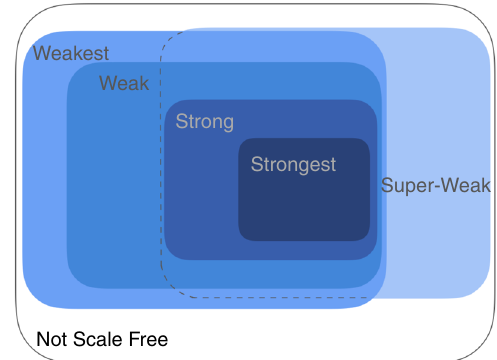
Fig. 2 Taxonomy of scale-free network de fi nitions. Super-Weak meaning that a power law is not necessarily a statistically plausible model of a network ’ s degree distribution but it is less implausible than alternatives; Weakest, meaning a degree distribution that is plausibly power-law distributed; Weak, adds a requirement that the distribution ’ s scale-free portion cover at least 50 nodes; Strong, adds a requirement that 2 < ^ α < 3 and the Super-Weak constraints; and, Strongest, meaning that almost every associated simple graph can meet the Strong constraints. The Super-Weak overlaps with the Weak de fi nitions and contains the Strong de fi nitions as special cases. Networks that fail to meet any of these criteria are deemed Not Scale